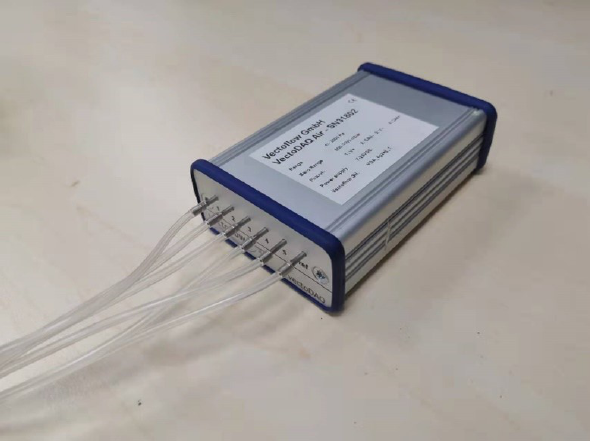
Figure 6. VectoDAQ Air Date Computer.